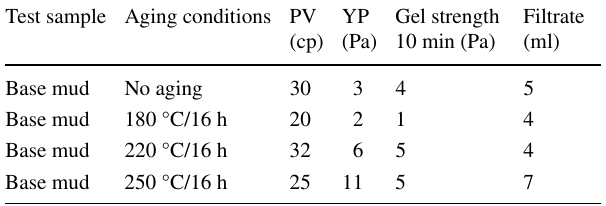
Table 3 Effect of temperature on mud